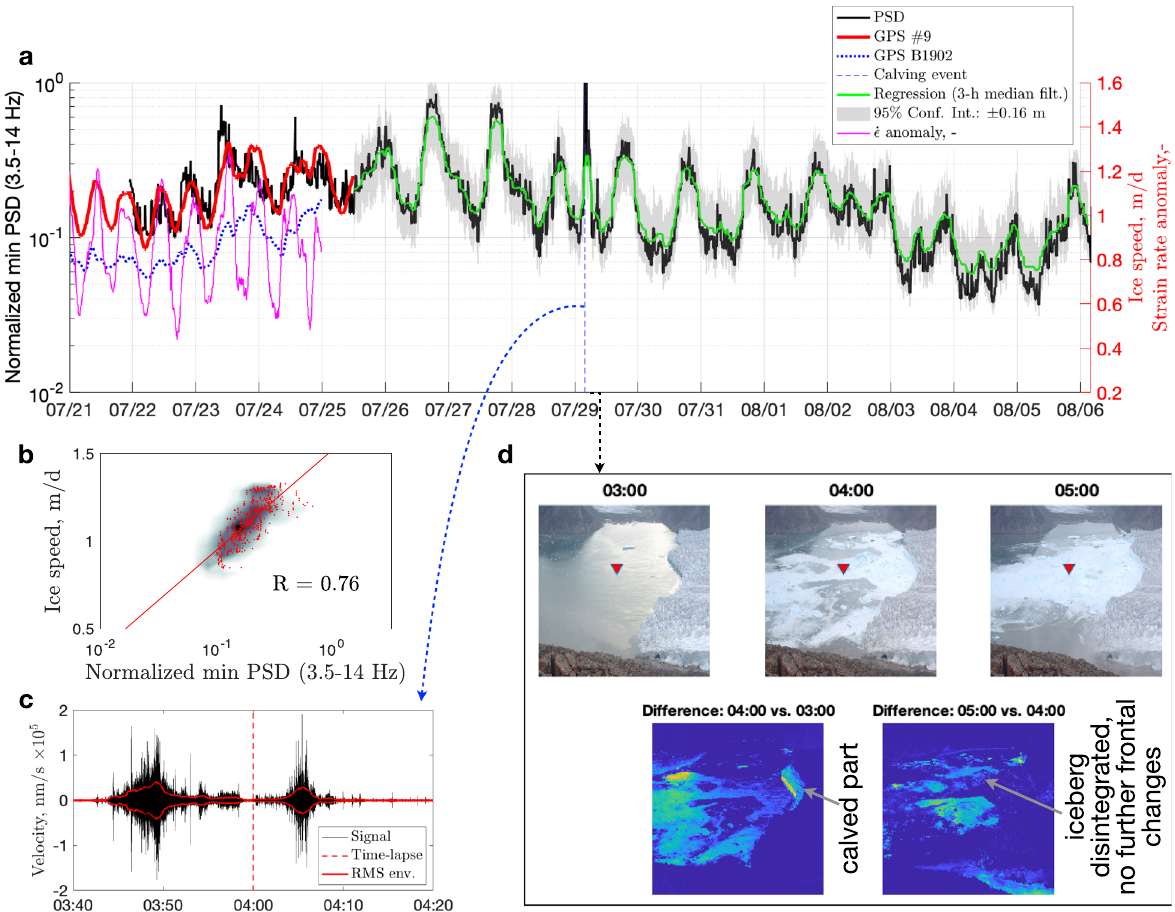
Fig. 3 Covariance between tremor amplitude and ice speed, 2019. a Seismic noise minimum amplitude (3.5 – 14.0 Hz power spectral density, PSD) versus glacier displacement rate at Global-Positioning-System (GPS) stations #9 and B1902, and the corresponding strain rate anomaly, _ ϵ (i.e., deviation from the mean). The predicted ice speed for the period with missing GPS data is shown in green; the 95% con fi dence interval (in grey) yields a 0.16 m uncertainty in the estimated speed. b Scatter and density plots showing the correlation between the seismic signal and horizontal displacement rate at GPS # 9 for overlapping data ( R is the Pearson correlation coef fi cient). The red line is the regression fi t. c Calving event as the cause of the main transient noise anomaly on 29 July (the signal is bandpass fi ltered at 1 – 10 Hz; the root-mean-square envelope with a 1-min moving window is shown in red; the times are in UTC). d Associated time-lapse images and their differences (i.e., direct subtraction of the greyscale intensity; the colour scale is in relative units, from 0 to ~100; the times are in UTC). The OBS drop location is marked by a triangle.